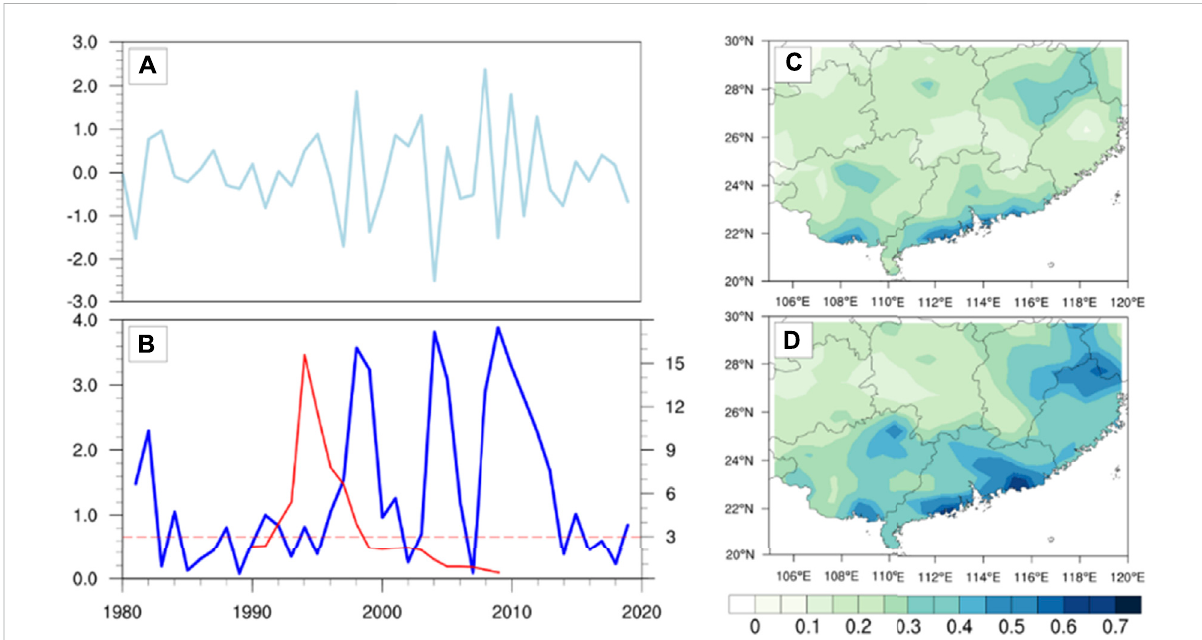
FIGURE 1 (A) Time Series and (B) absolute values of interannual difference (blue line, normalized, interannual difference refers to the difference between thecurrentyearandlastyear)and10-yearrunning F testvalues(redline)ofintraseasonalrainfall(30 – 90days fi lteredsummerrainfallanomalies)over SC (the red dashed line in b indicates signi fi cant values exceeding the 95% con fi dence level). Spatial patterns of SC intraseasonal rainfall variance for the periods (C) 1980 – 1996 and (D) 1997 – 2019,